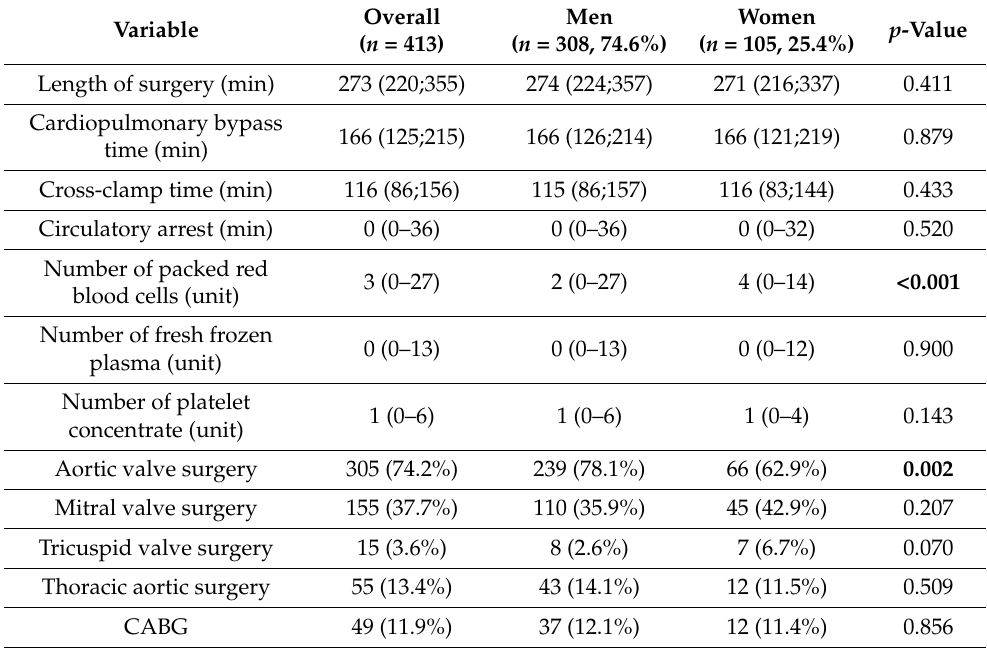
Table 2. Operative data stratified by gender.